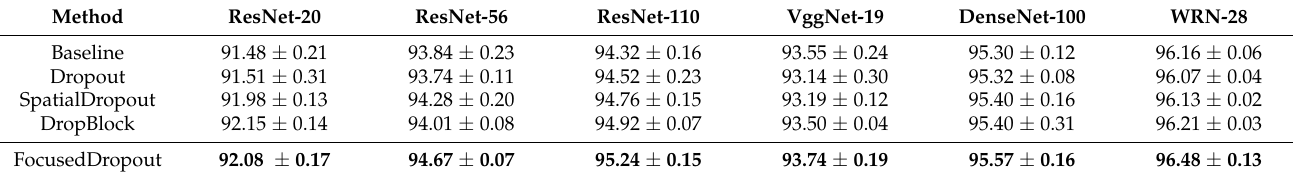
Table 1. Test accuracy (%) on CIFAR10 dataset using CNN architectures of ResNet-20, ResNet-50, ResNet-110,VggNet-19, Densenet-100,Wide ResNet-28 (Top accuracy is in bold). We report the average over 3 runs.